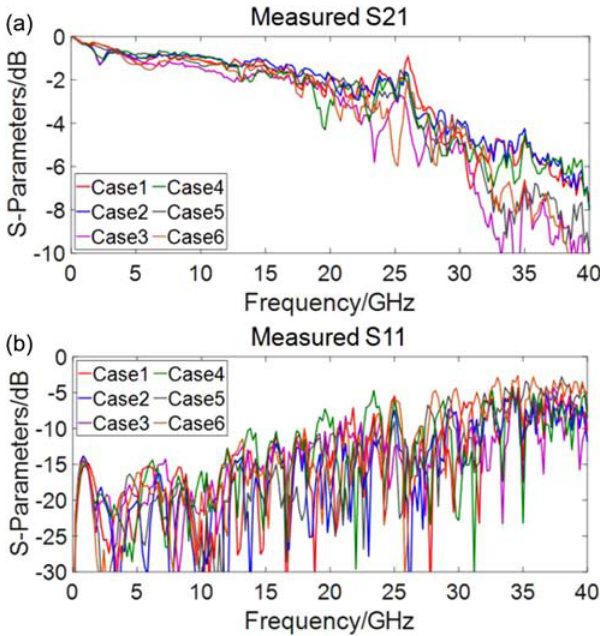
Fig. 6. (a) The measured S21 for the 6 cases of the SSPP TLs. (b) The measured S11 for the 6 cases of the SSPP